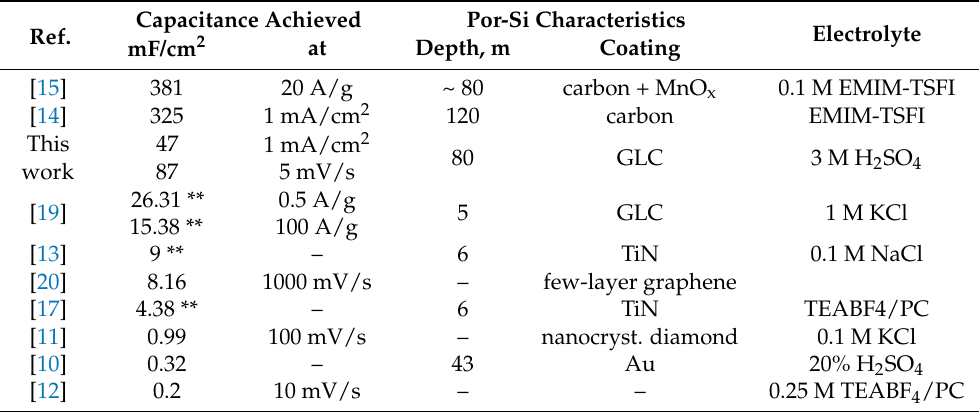
Table 2. The capacitance data obtained by different authors for por-Si with various coatings. Capacitance Achieved Por-Si Characteristics Ref. mF/cm 2 at Depth, m Coating